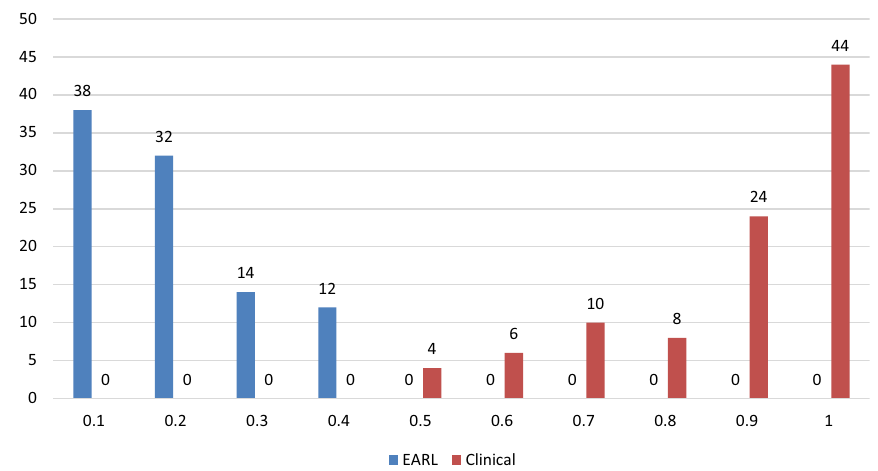
Fig. 3 Probabilities of the first network to identify images reconstructed with clinical reconstruction settings. If the probability is below 0.5 for an EARL compliant image, this image is correctly classified As illustrated, the network can separate well between EARL compliant and clinical reconstructions